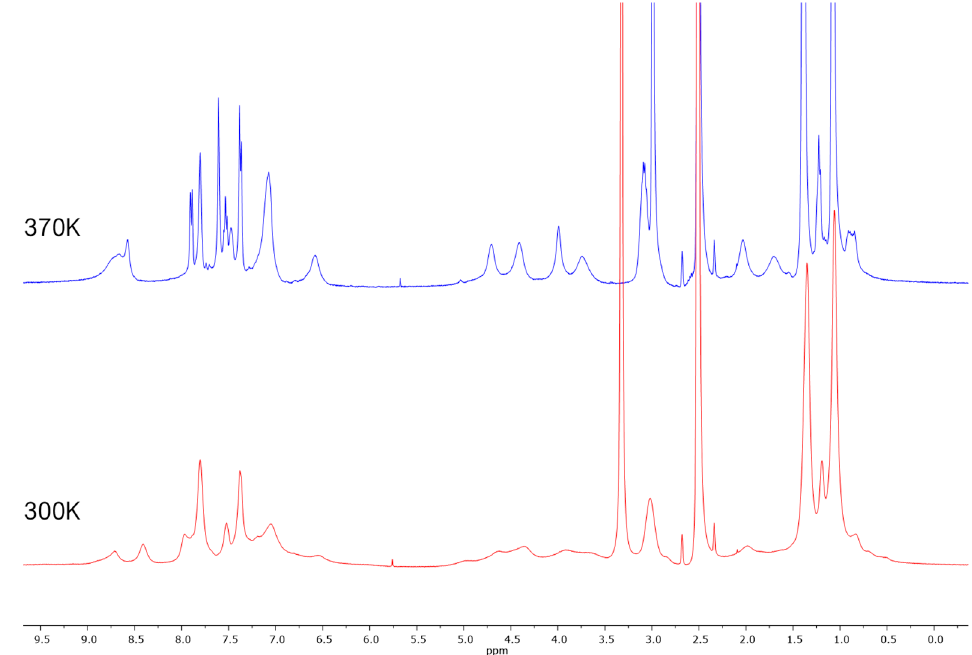
Figure 3. Stack plot of 1 H NMR spectra of Calx-IPr obtained at 370 K (Top) and 300 K (Bottom).